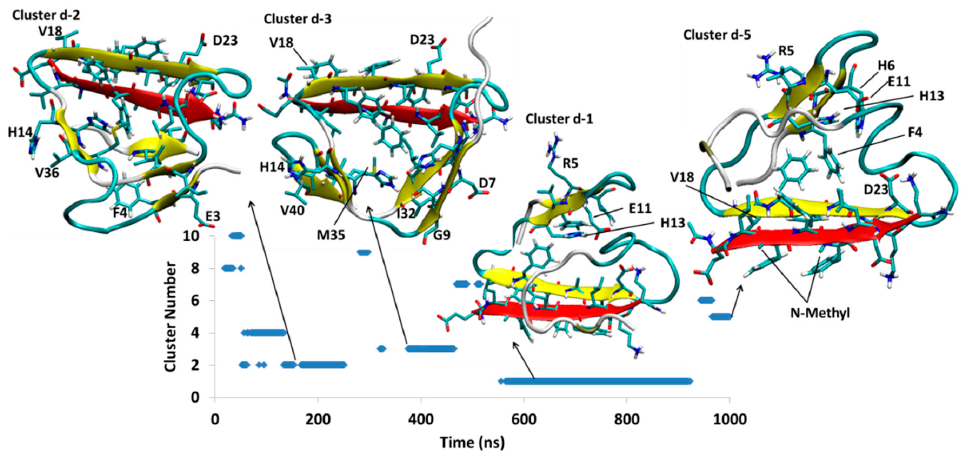
Figure 11. A β B -SGD1-d. Clusters Dd1, Dd2, Dd3 and Dd5 are shown.